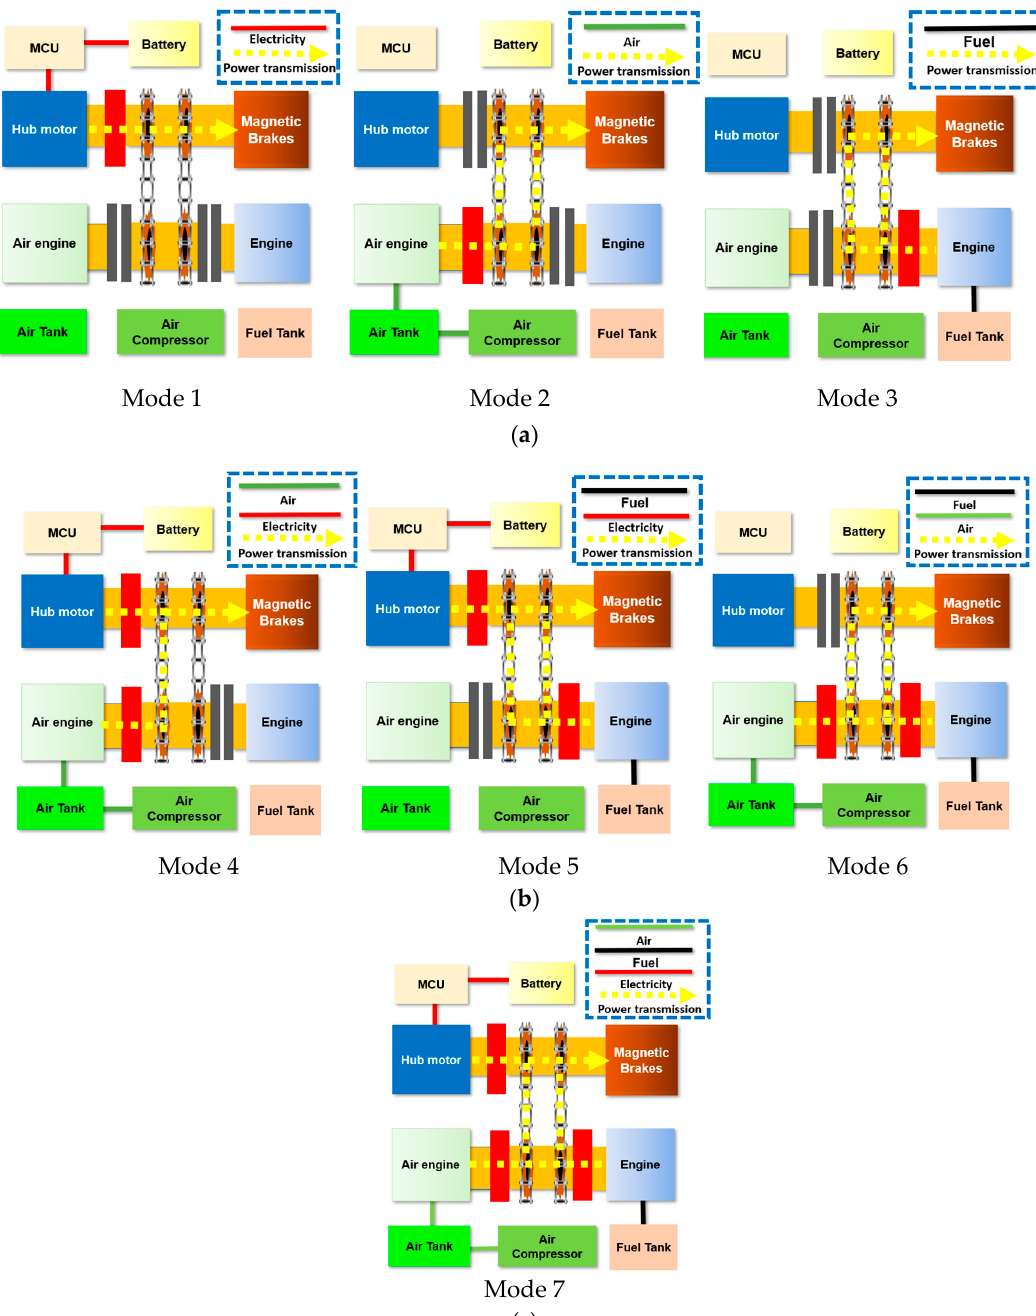
Figure 3. Energy (Power) flow of the seven modes: ( a ) Single-source (engine, motor, air engine) mode; ( b ) Dual-source (engine/motor, motor/air engine, engine/air engine) mode; and, ( c ) Triple-source mode .